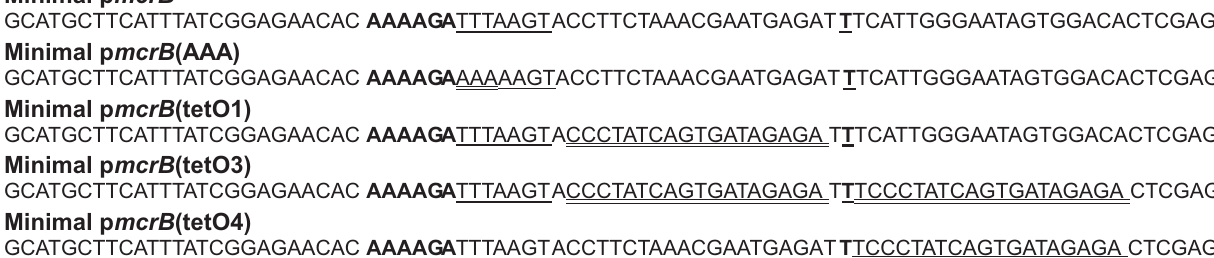
Figure 4. Nucleotide sequence of the mcrB promoter and mutated derivatives. The nucleotide sequence of the minimal mcrB promoter from Methanosarcina barkeri is shown on the top line. The putative BRE is shown in bold text, the putative TATA box is underlined and the experimen- tally verified transcription start site (Allmansberger et al. 1989) is underlined in bold text. The following lines show the mutated derivatives that were modified to include the tetR -binding site (double underlined) at various positions within the